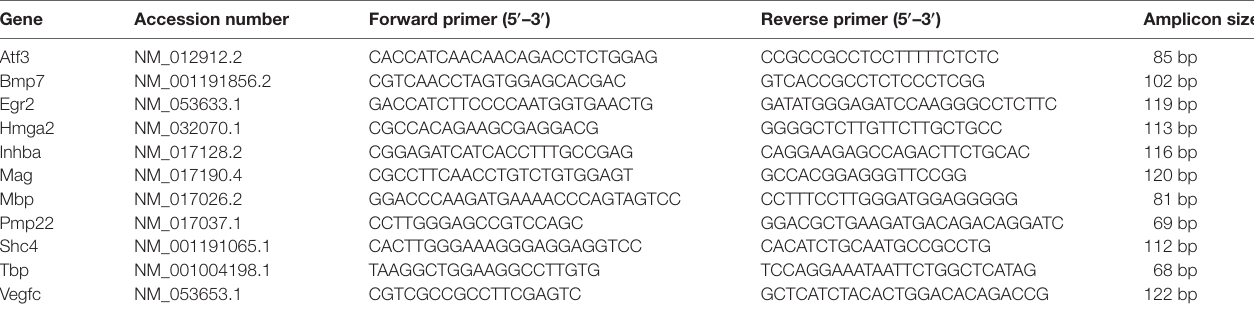
TABLE 1 | List of primers used for quantitative real time PCR (qRT-PCR) analysis to validate deep sequencing results.